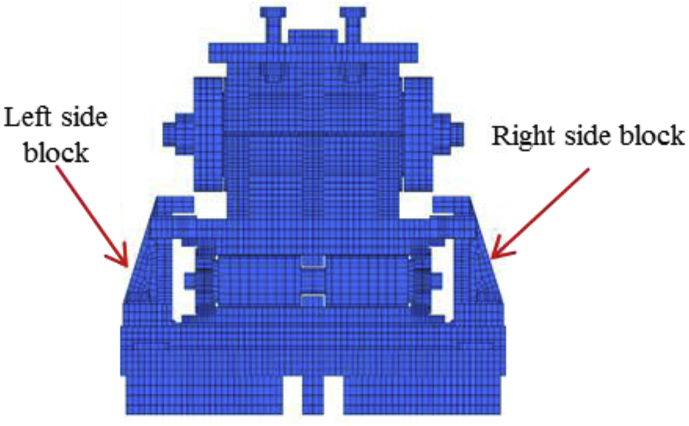
Side blocks Layout.